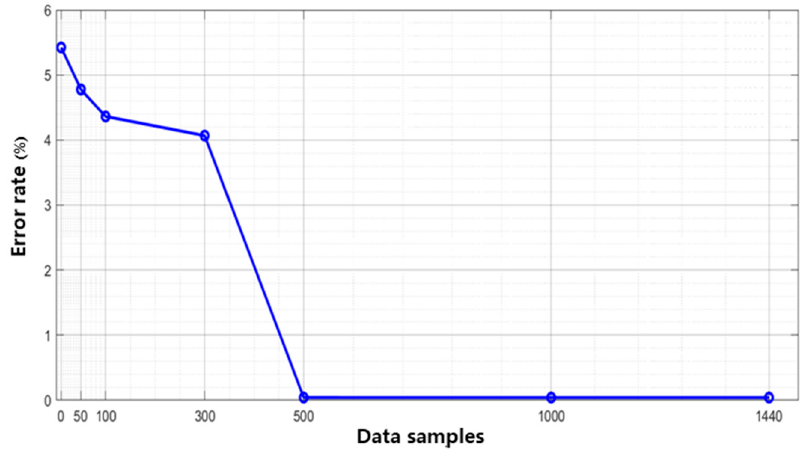
Figure 12. The saturation point of the HV-ML model was obtained by using sample